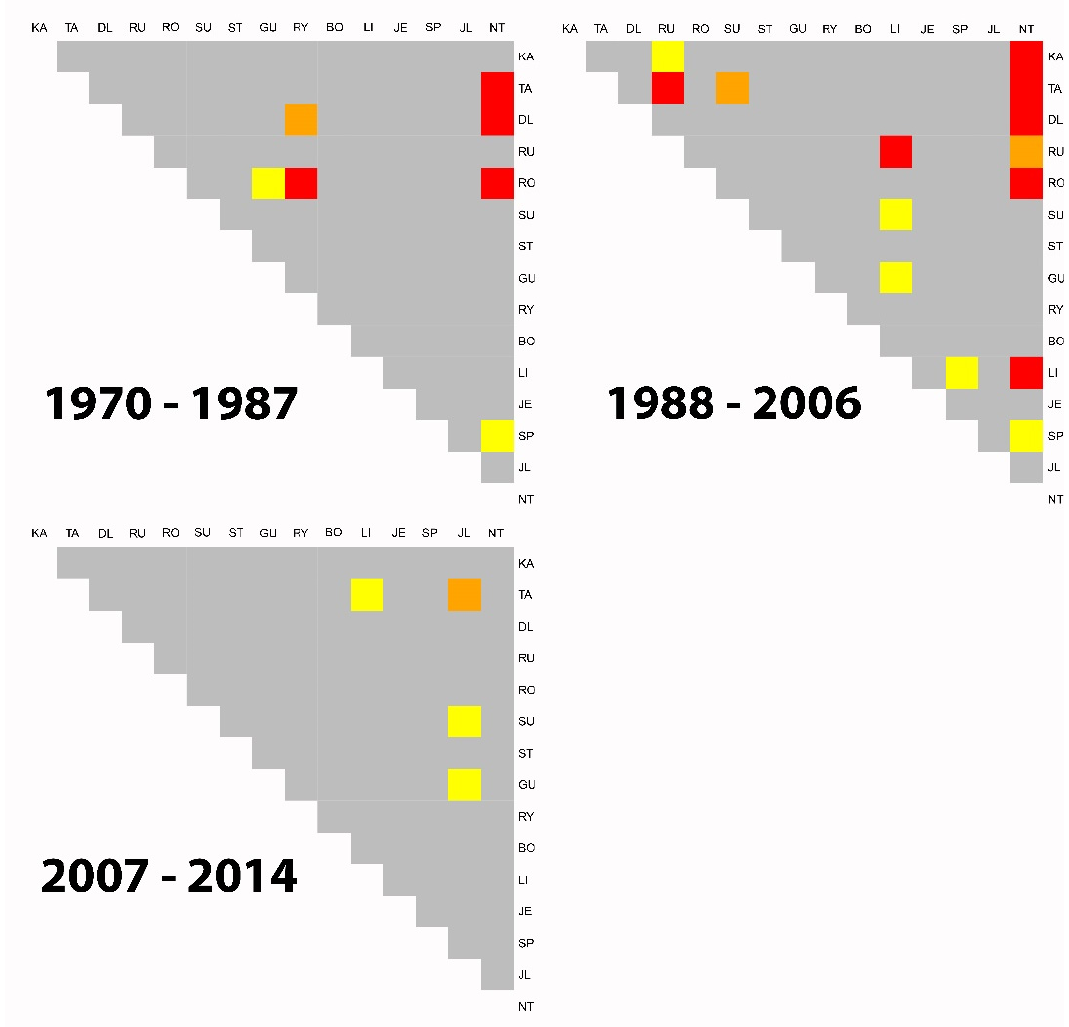
Figure 4. Probability value of Wilcoxon rank–sum test (Bonferroni correction) used to demarcate a significant di ff erence in principal component gradient analysis (PCGA)–ranks between provenances